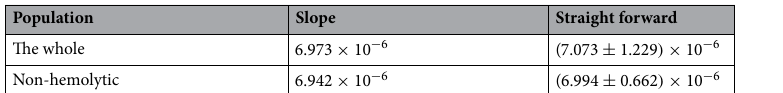
Table 3. k g estimation. Results obtained by the direct method are expressed as mean ± standard deviation (SD).